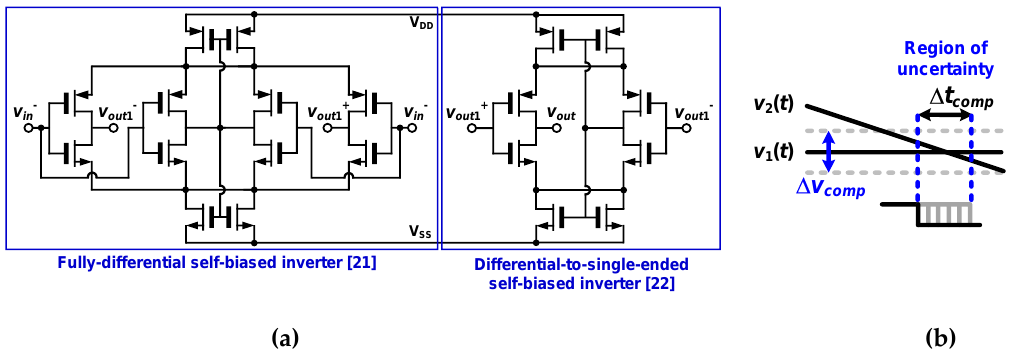
Figure 15. ( a ) Schematic of comparators and ( b ) the uncertainty caused by comparators during Figure 15. (a) Schematic of comparators and (b) the uncertainty caused by comparators during time time interpolation.